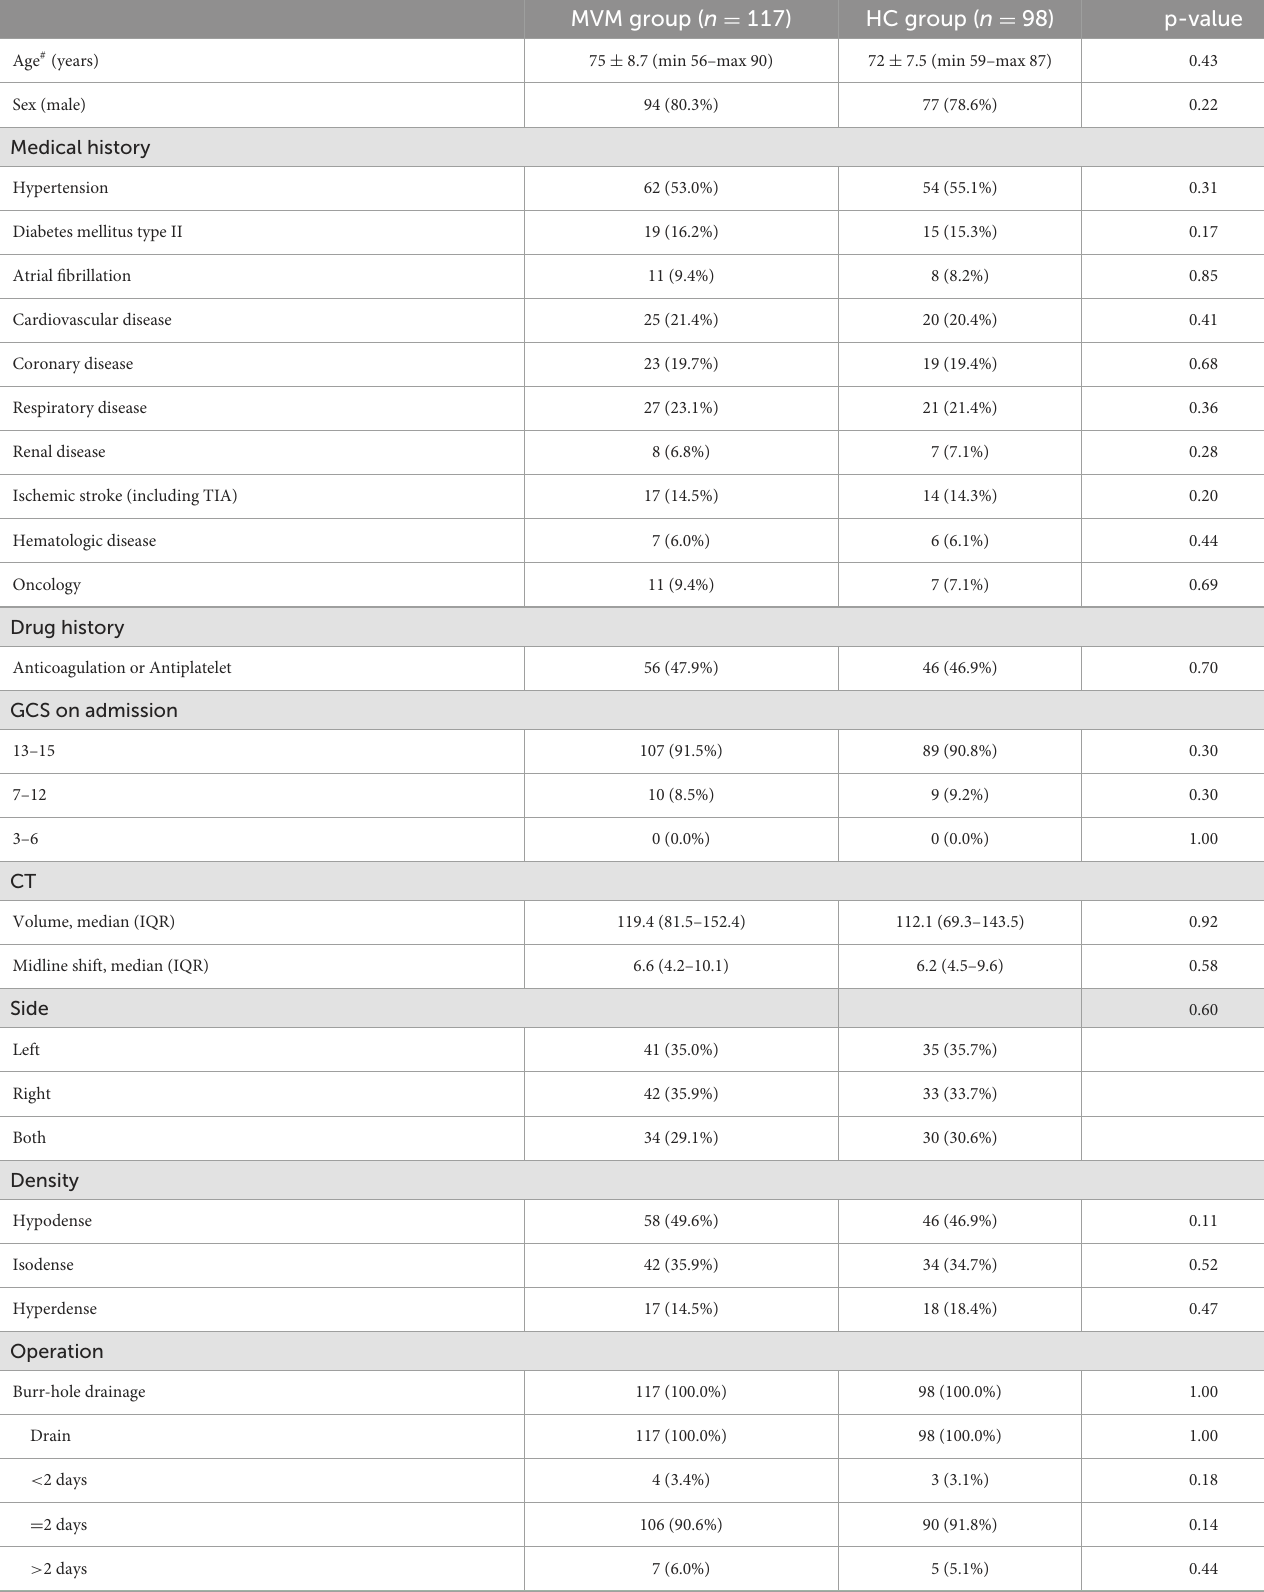
TABLE 1 ∗ Demographic data ( N =